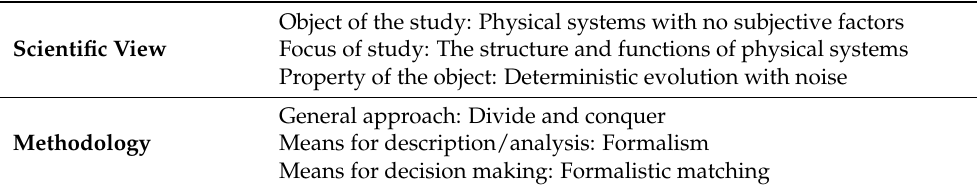
Table 2. Major features of the paradigm actually executed in the information